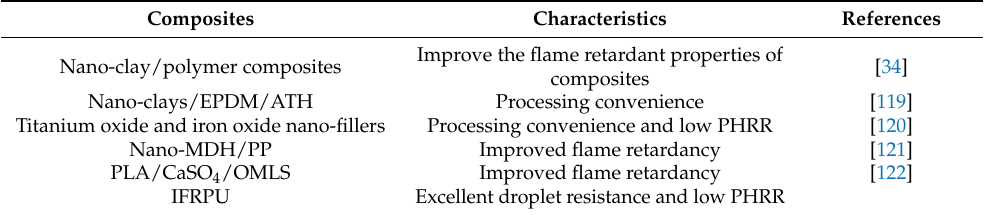
Table 5. Flame-retardant composites containing nano-filler and their characteristics. Composites